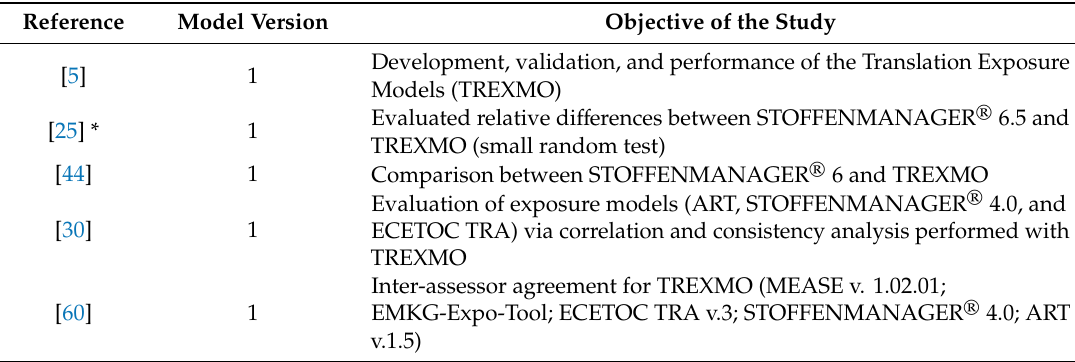
Table 11. Summary of articles found about the TREXMO tool for the present